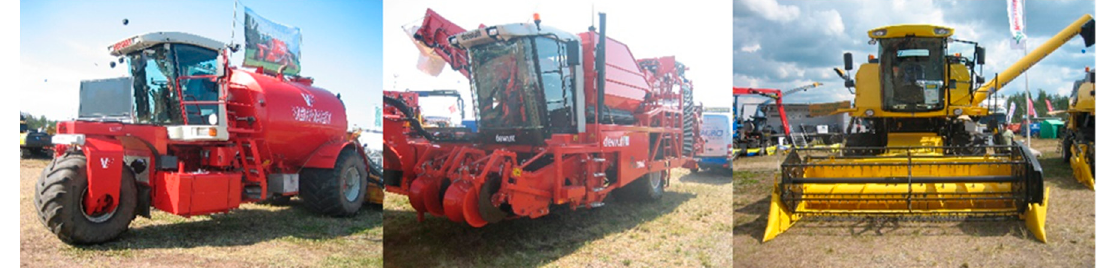
Figure 1. Examples of self-propelled agricultural machinery: Vervaet slurry spreader, Dewulf potato harvester, and New Holland TC5050 combine harvester (Photos: Antti Lajunen).